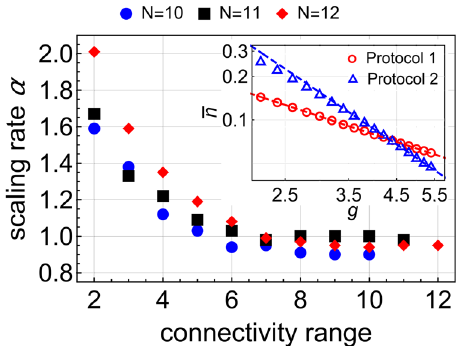
Fig. 4 Annealing for systems with the fi nite connectivity range. The scaling rate, α , was obtained by fi tting numerically obtained excitation numbers with h n i (cid:7) 1 = τ α , for various interaction ranges of the Hamiltonian a H I and the transverse fi eld protocol (Protocol 2 in Table 1). The inset shows a comparison of the typical power-law decay for such fi ts of the data for protocols 1 and 2 with N = 12 spins under a range-2 (only binary spin-spin couplings)